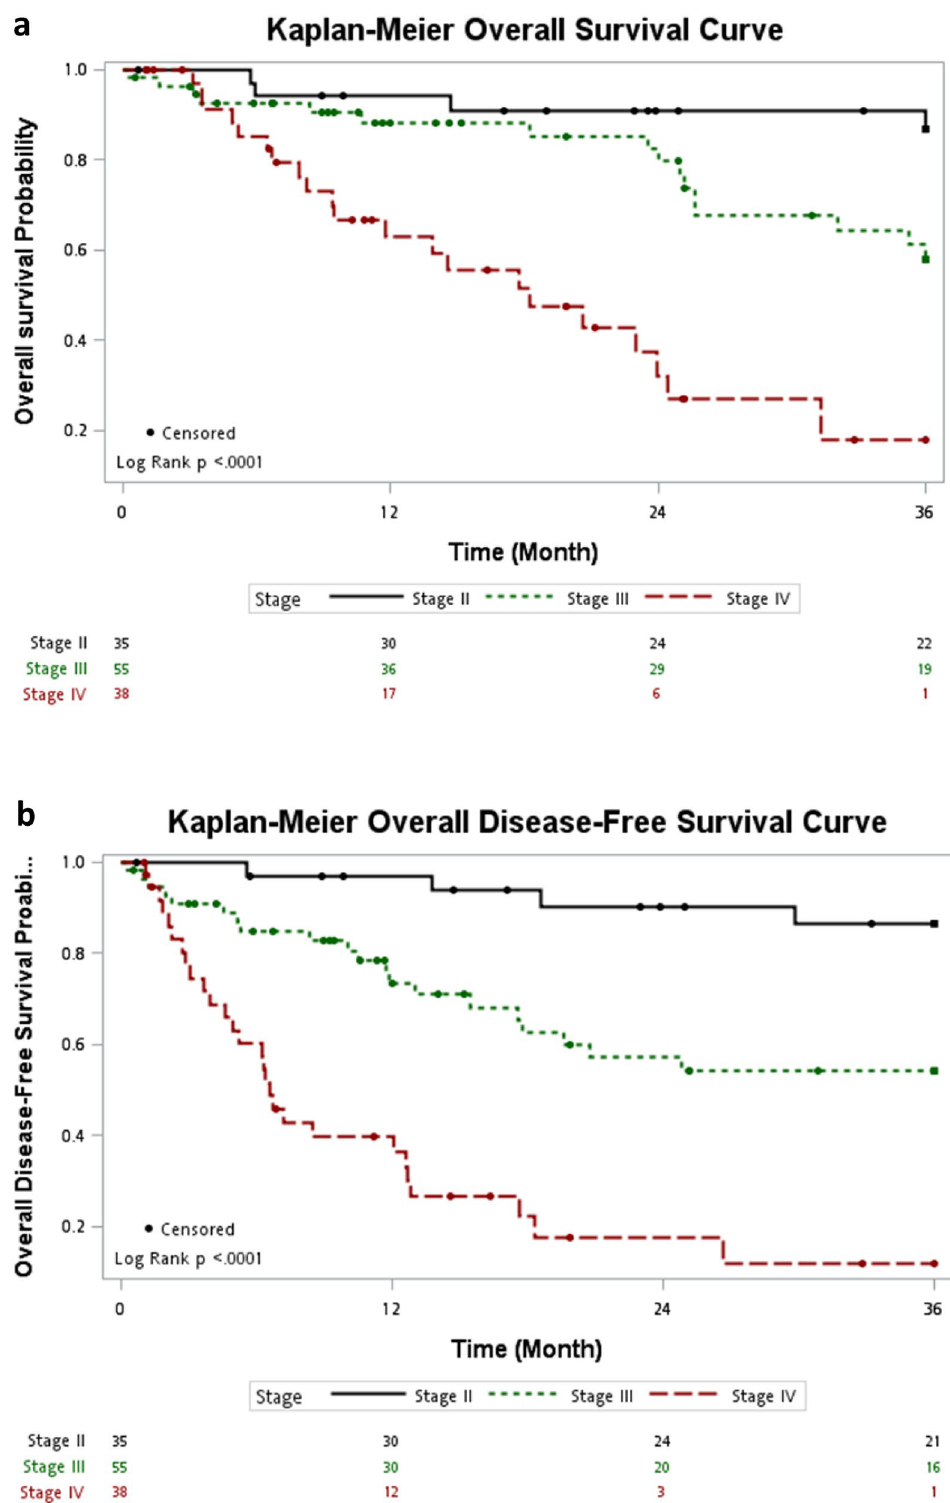
Figure 2. ( a ) Overall survival according to the tumor-node-metastasis (TNM) stages. ( b ) Disease-free survival according to the tumor-node-metastasis (TNM)